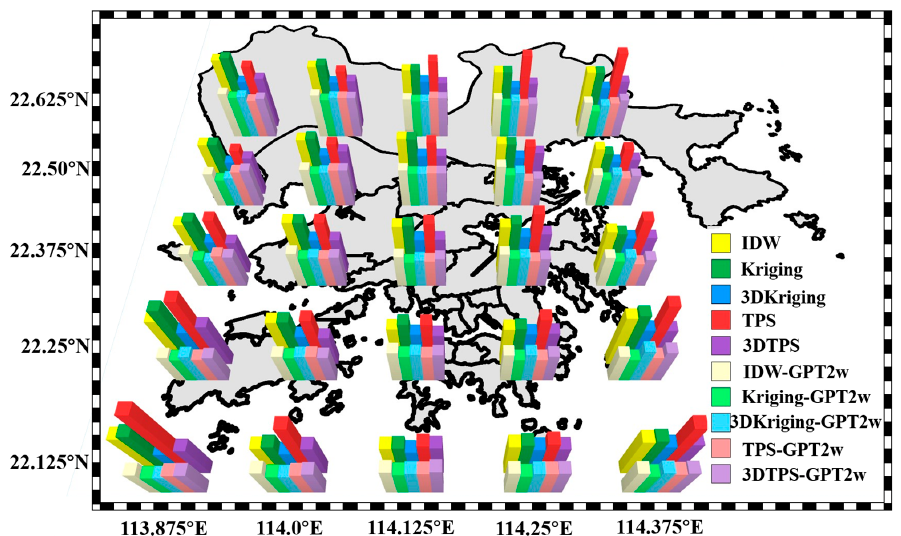
Figure 6. Histogram of RMSE at 25 grid points for the 10 interpolation schemes.